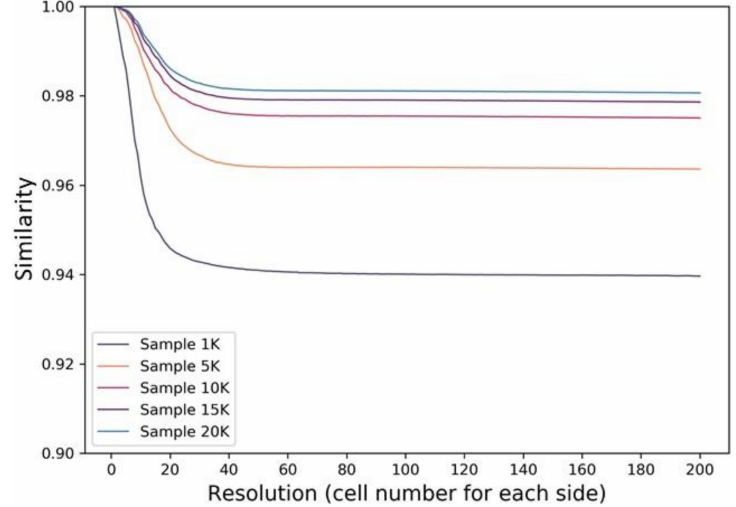
Figure 13. The relationship between similarity and the resolution of input